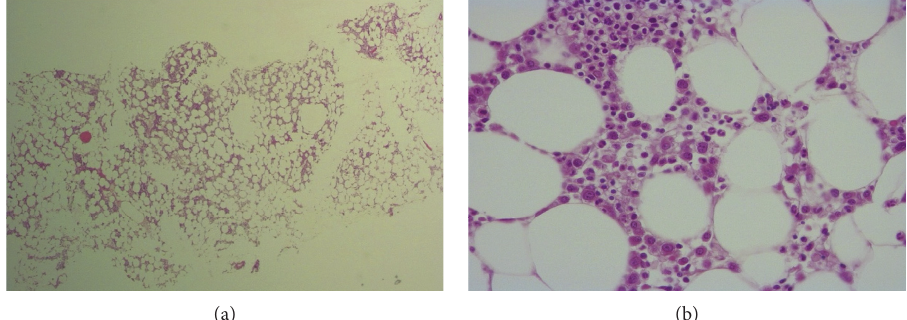
Figure 2: Histology of bone marrow (hematoxylin-eosin staining). (a) Severe marrow hypoplasia (cellularity between 10% and 30%). (b) Histologic exam of bone marrow showing reduced presence of elements of the three cell lineages with left shift of the myeloid maturation. No blastic, dysplastic, or lymphoma cells were